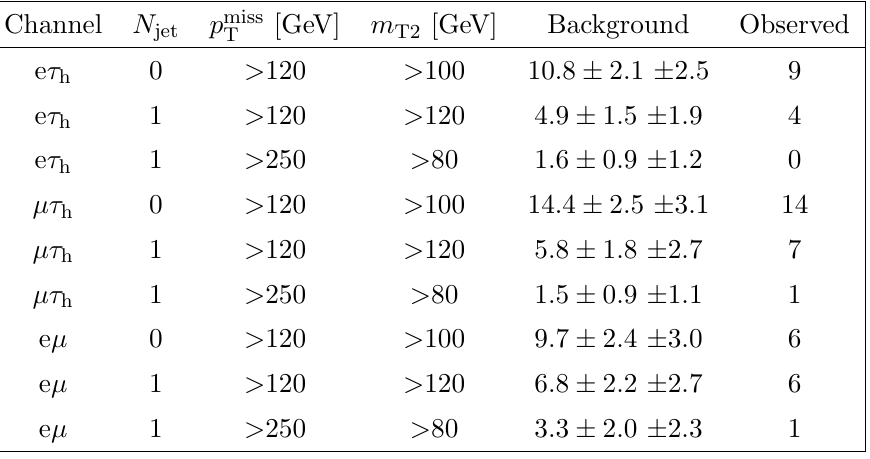
Table 11. De(cid:12)nition of the aggregate SRs to be used for easier reinterpretation of the results in the e (cid:28) h , (cid:22)(cid:28) h , and e (cid:22) (cid:12)nal states. In all of these regions, a selection requirement of D (cid:16) > (cid:0) 500 GeV is